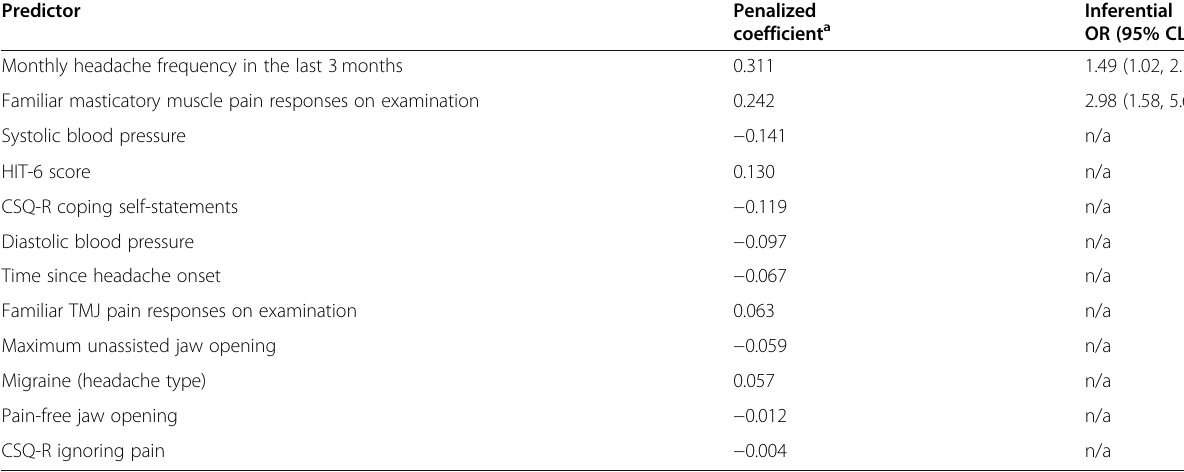
Table 3 Multivariable lasso regression model of characteristics distinguishing between presence versus absence of HATMD